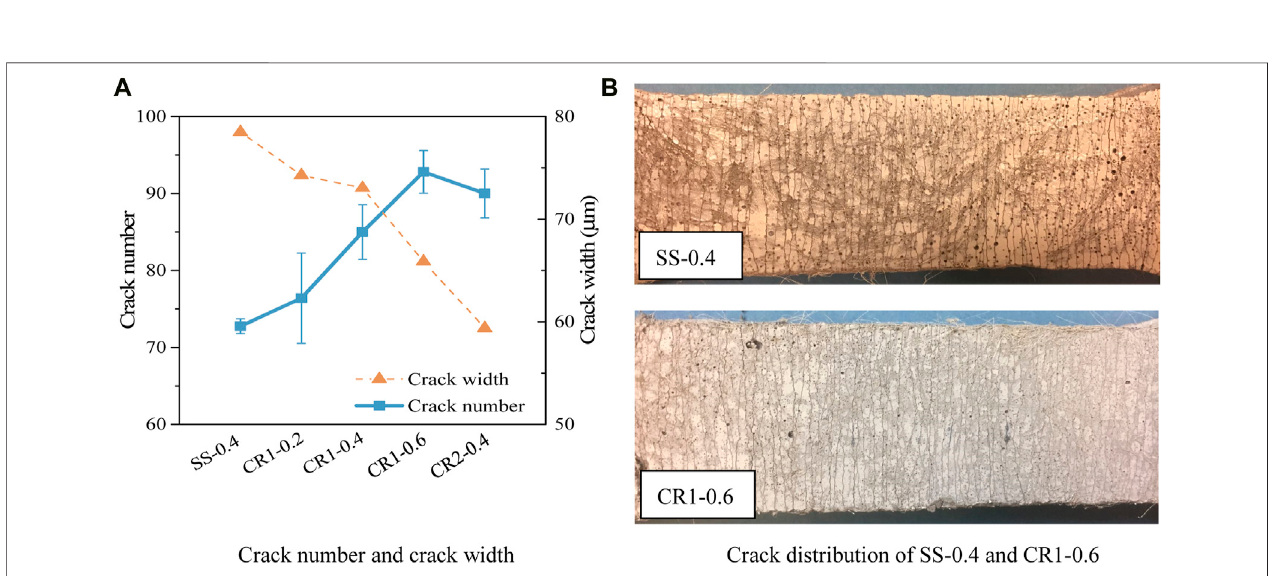
FIGURE 7 | Crack parameters of HS-ECC. (A) Crack number and crack width. (B) Crack distribution of SS-0.4 and CR1-0.6. HS-ECC, high-strength engineered cementitious composite.